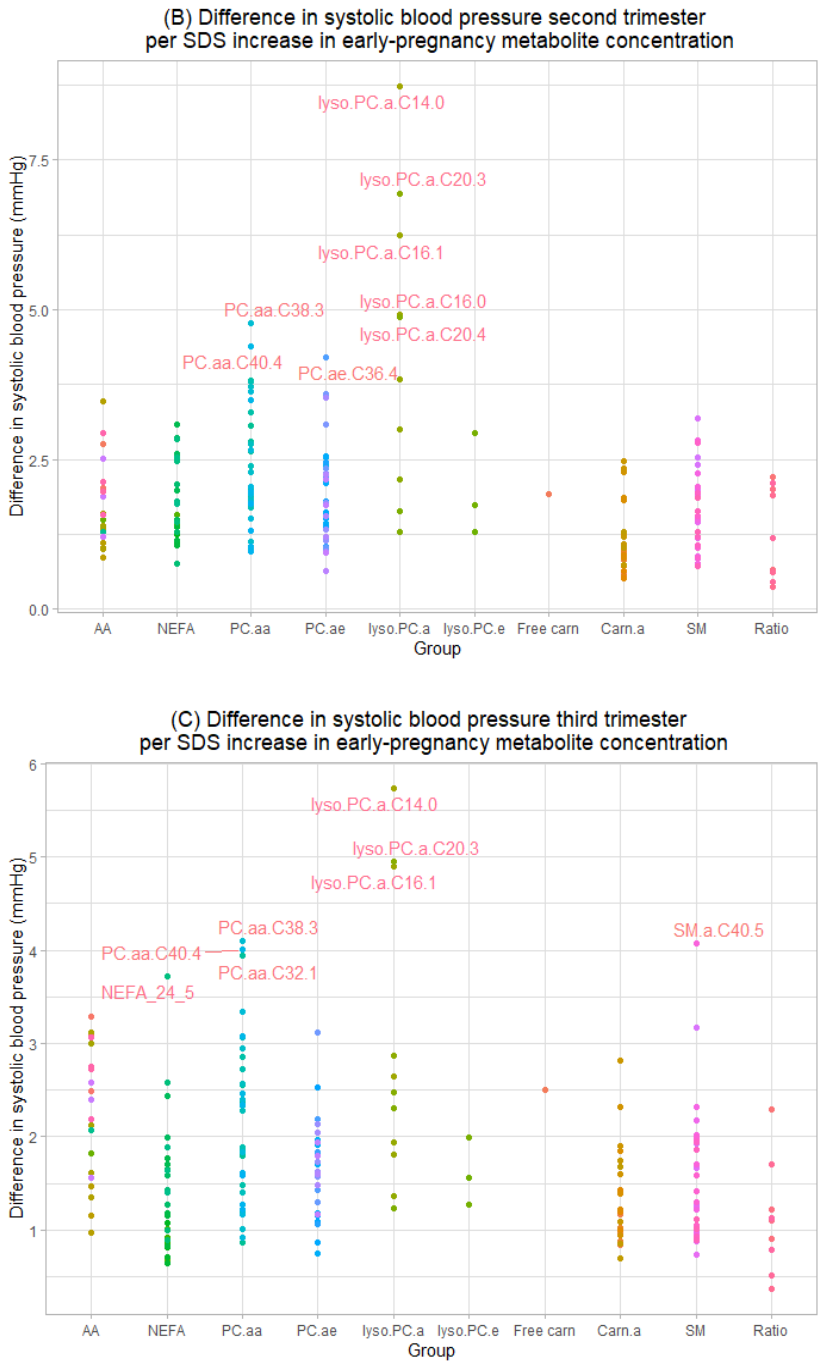
Figure 1. Associations of maternal serum early-pregnancy individual metabolites with systolic blood pressure in ( A ) early-, ( B ) mid- and ( C ) late pregnancy. Values represent absolute differences in blood pressure from linear regression models that reflect the difference in blood pressure (mmHg) per SDS increase in maternal early-pregnancy metabolite concentrations ( µ mol/L). Model includes gestational age at time of measurement, age, parity, pre-pregnancy body mass index, educational level, smoking and folic acid supplementation. Labeled values represent significant associations (FDR-adjusted p -values < 0.05). Corresponding numerical values are shown in Table S4. AA amino acids, NEFA non-esterified fatty acids, PC.aa diacyl-phosphatidylcholines, PC.ae acyl-alkyl-phosphatidylcholines, lyso.PC.a acyl-lysophosphatidylcholines, lyso.PC.e alkyl-lysophosphatidylcholines, Carn.a acyl- carnitines, SM